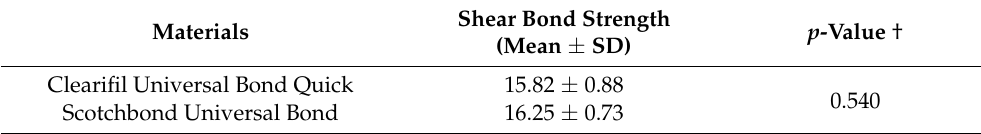
Table 1. Mean values and standard deviation (MPa) of the shear bond strength.